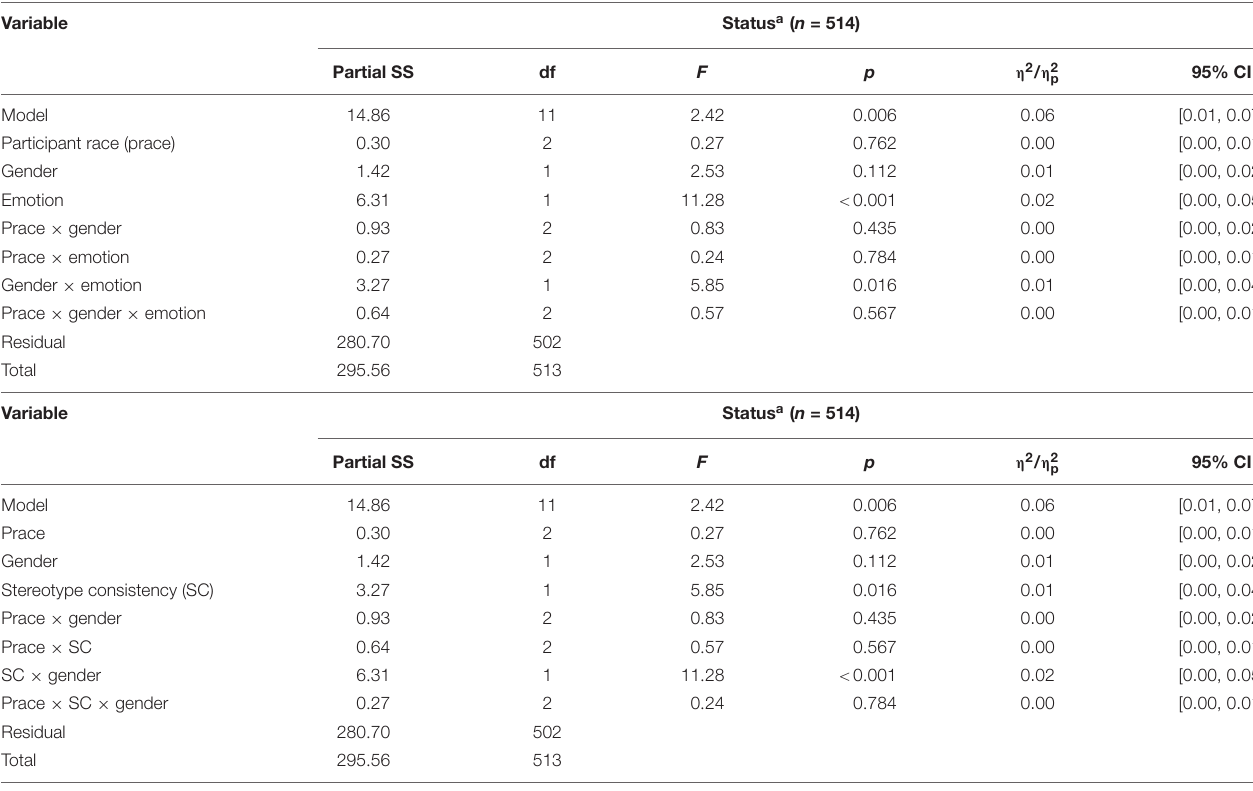
TABLE 4 | Effects of gender, emotion, stereotype consistency and participant race on standardized status.